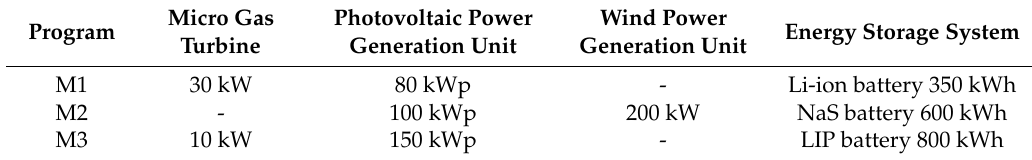
Table 2. Three micro-grid planning programs.